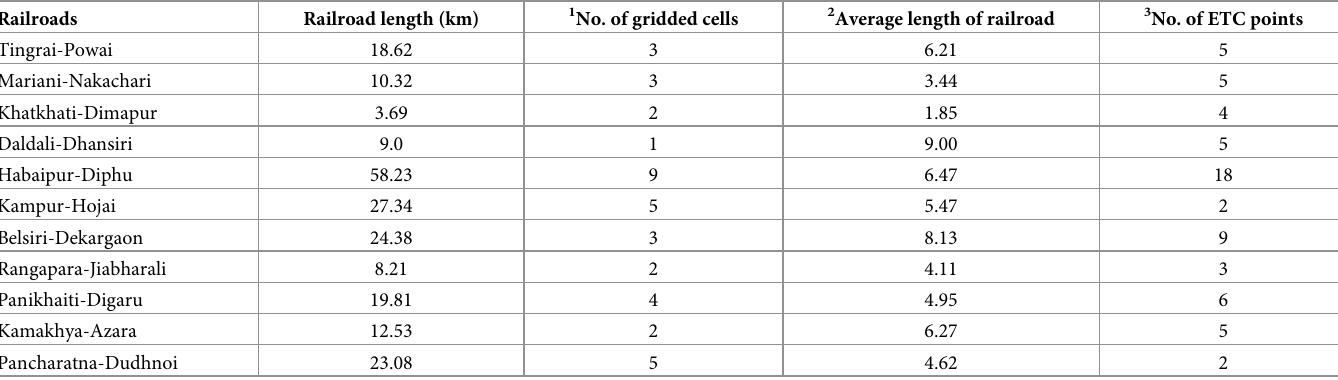
Table 2. Length estimates of the sample railroads and number of ETC